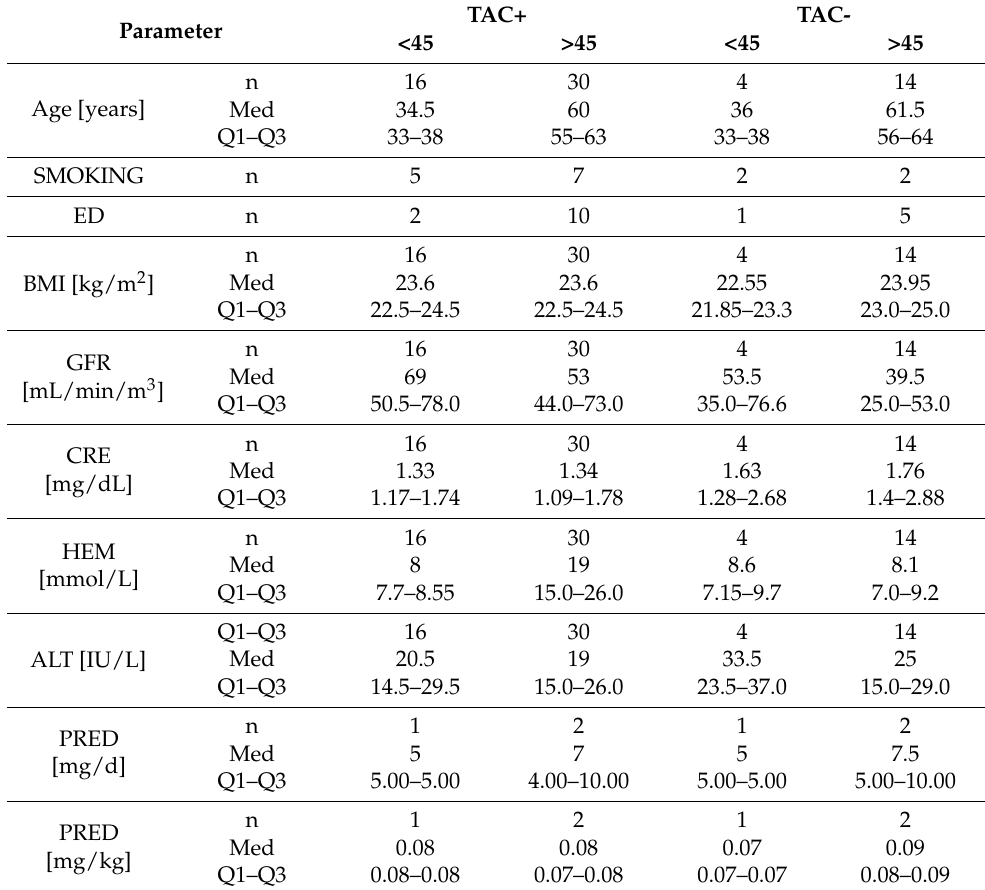
Table 2. Demographical and clinical data of